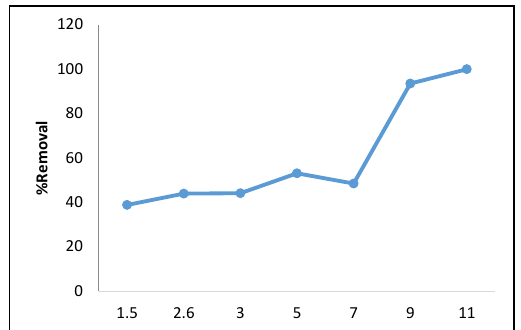
Fig. 8. The removal efficiency Cr (VI) by ferrous sulfate at different ferrous sulfate dosages (g/l)